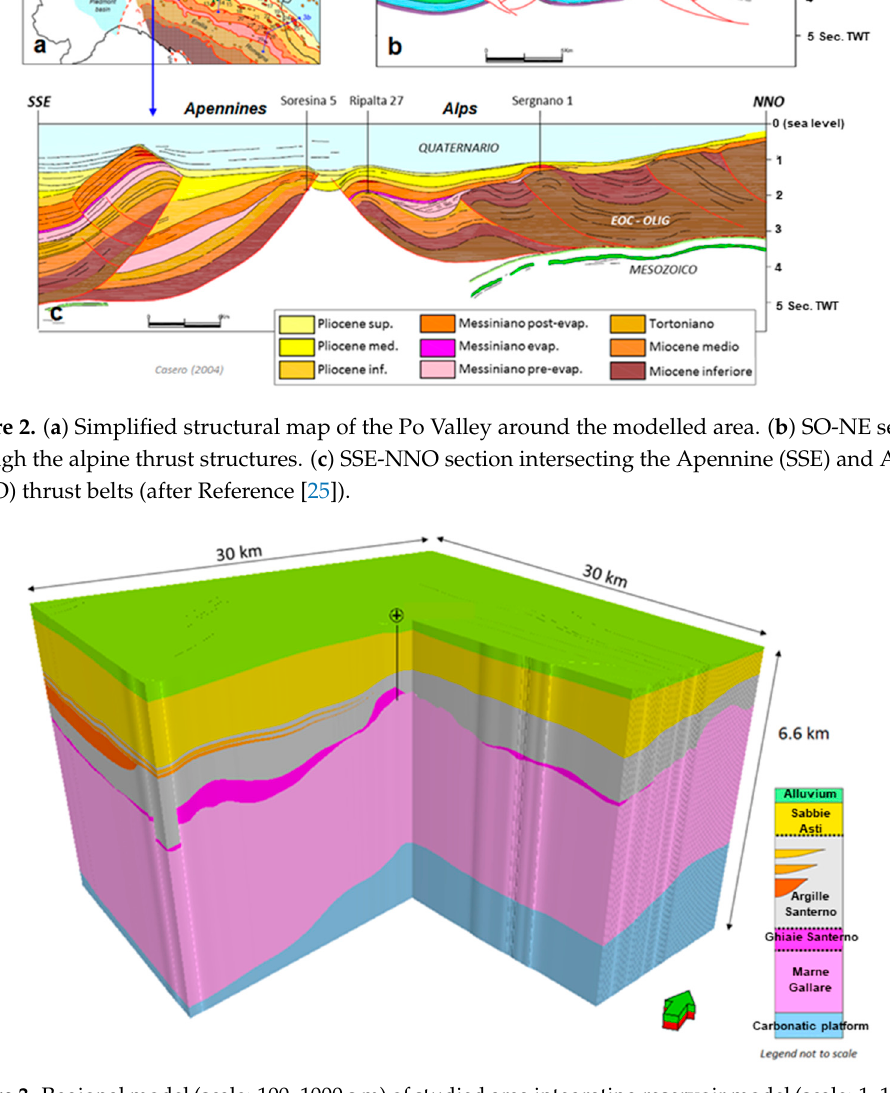
Figure 3. Regional model (scale: 100–1000 s m) of studied area integrating reservoir model (scale: 1–10 s m). Reservoir is located in central zone (see well location).